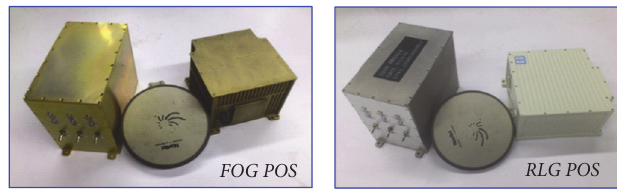
Figure 4: Airborne POS developed by